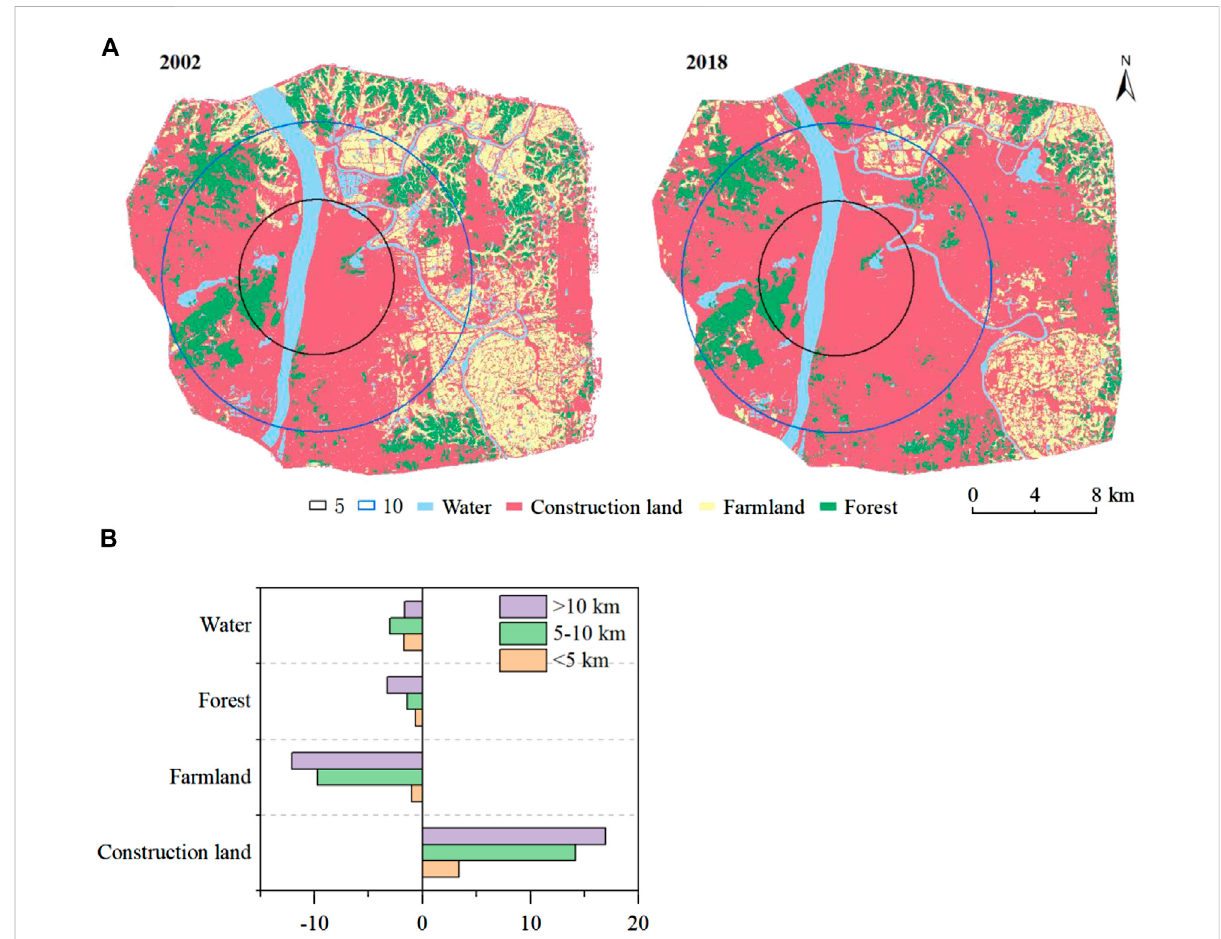
FIGURE 2 (A) Land-use in Changsha between 2002 and 2018 and (B) land-use change in different distance bands between 2002 and 2018